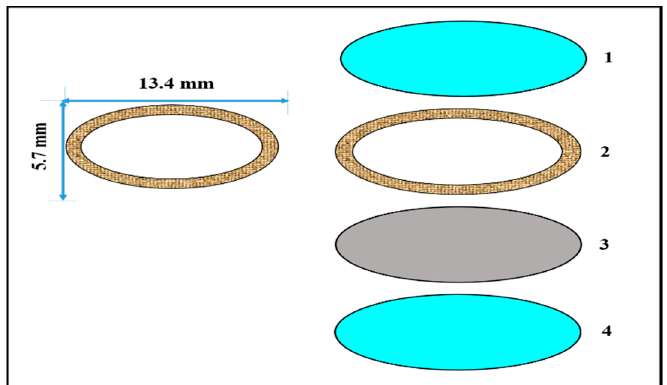
Figure 14. Ocusert: (1) and (4) show transparent polymer membranes, (2) shows a titanium dioxide white ring, and (3) shows a pilocarpine core reservoir (adapted from [136]).